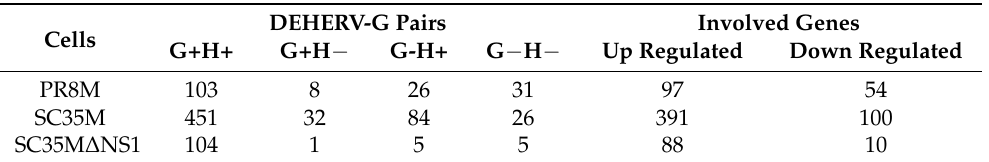
Table 3. Differential expression status of DEHERV-G pairs in the three cell types. Symbols +/ − denote up/down-regulation of genes or HERVs, respectively. e.g., G+H+ indicates pairs in which both a HERV locus and a gene are